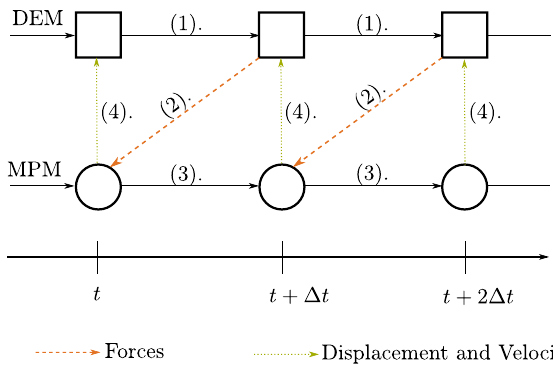
Fig. 3 Gauss-Seidel communication pattern for the partitioned weak MPM-DEM coupling scheme. Steps (1)–(4). are explained by Algorithm 1